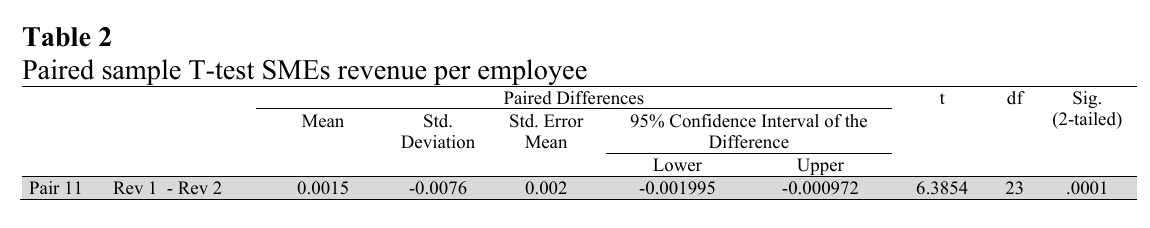
Paired sample T-test SMEs customer satisfaction